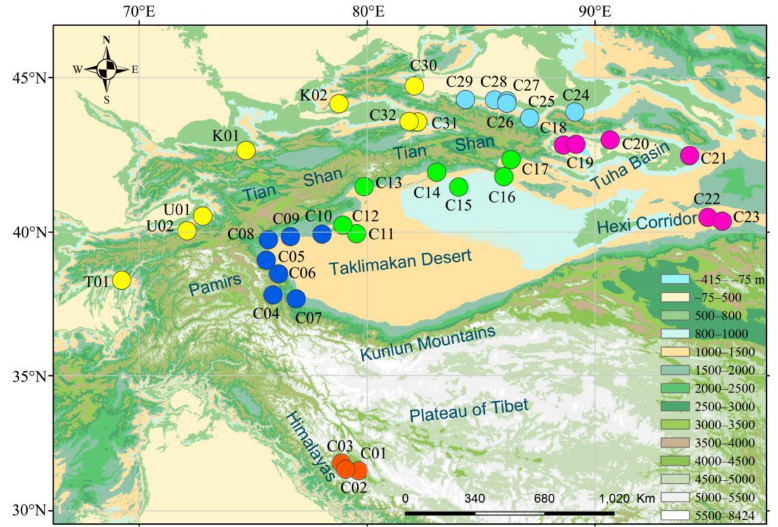
Figure 2. Natural geographical distribution of C. spinosa populations in arid central Asia. Different colors distinguish different geographic groups with red (western Himalayas), blue (eastern Pamirs), yellow (western Tianshan), azure (northern piedmont of Tianshan), green (southern piedmont of Tianshan) and purple (eastern Tianshan). The SRTM elevation data at a resolution of 30 s was downloaded from the WorldClim (https://www.worldclim.org/ accessed on 22 October